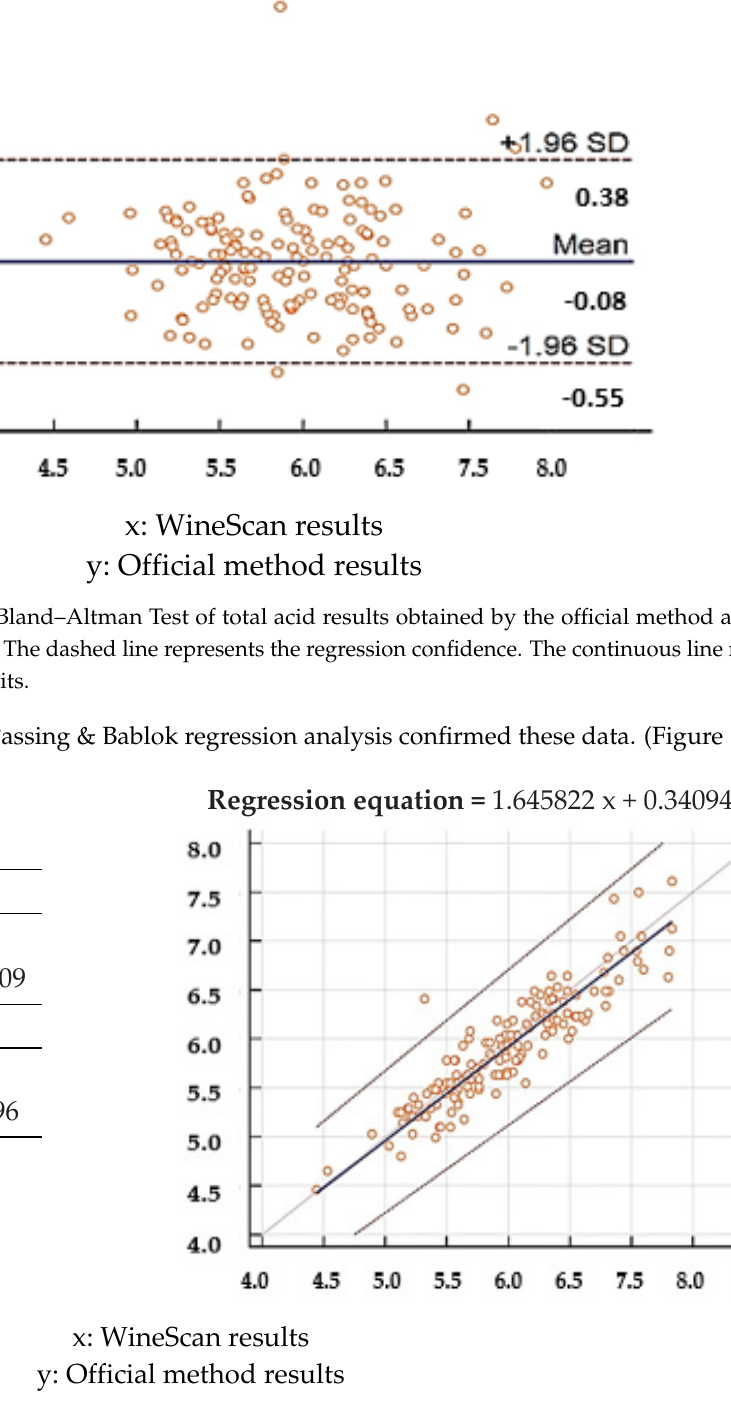
Figure 13. Passing & Bablok regression analysis of total acid results obtained by the official method and WineScan technology. The line y = x is represented by the dashed line. The regression line corresponds to the solid line.